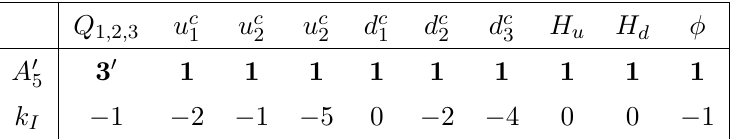
Table 6. The representations and the modular weights of the quarks. This is an explicit model for superpotential with Yukawa coupling of 3 0 in A 0